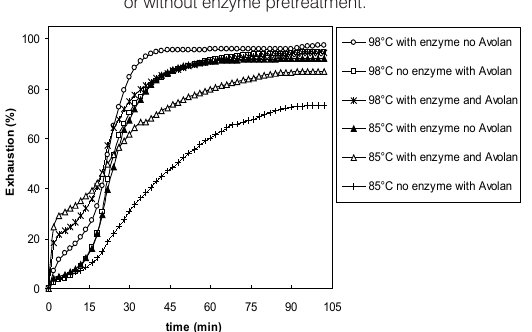
Figure 2. Exhaustion curves of Telon Turquoise on wool dyed with Avolan S, with or without enzyme pretreatment.